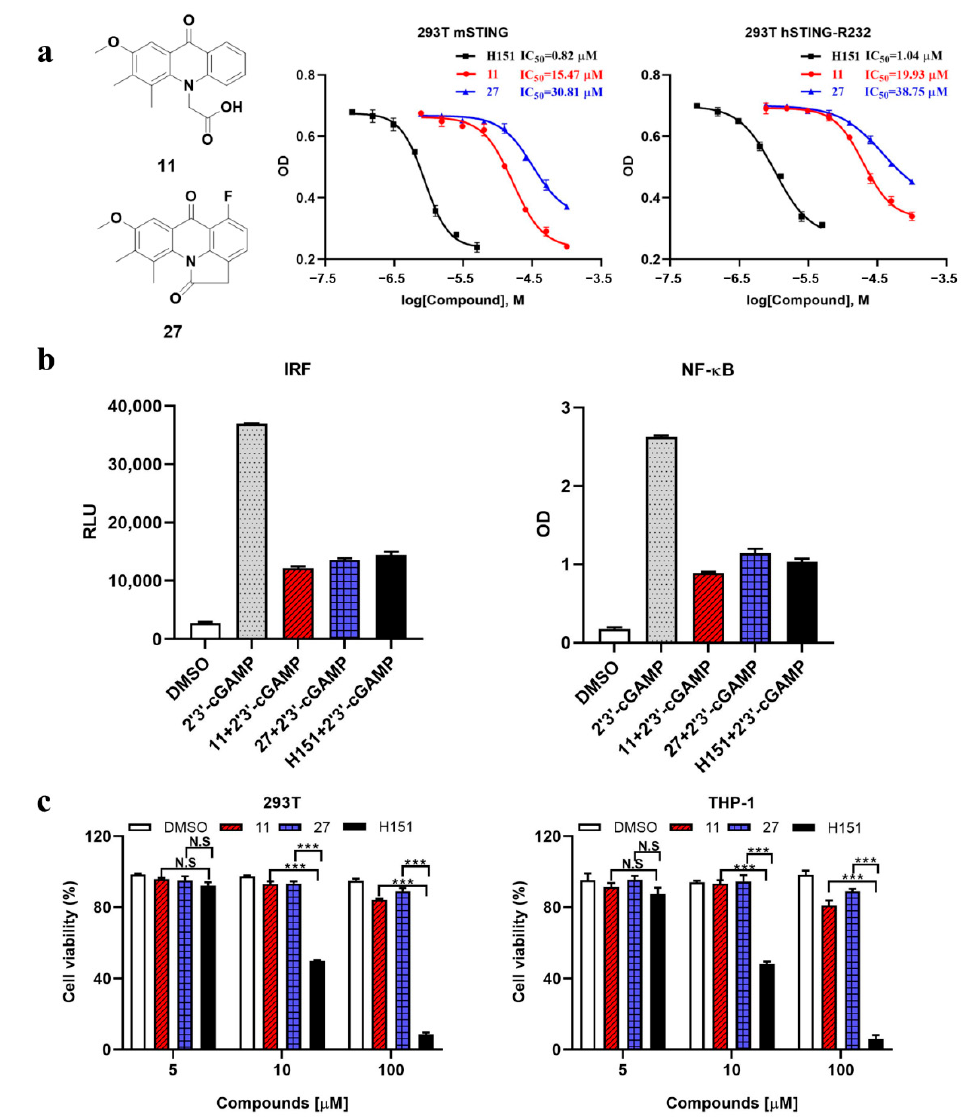
Figure 7. Broad-spectrum STING-binders 11 and 27 are STING antagonists. ( a ) Chemical structures of compounds 11 and 27 , and the inhibitory activity of STING inhibitors against both m- and h- STING pathways. 293T cells (mSTING or hSTING), pretreated with different concentrations of compounds were stimulated by 2 ′ ,3 ′ -cGAMP; inhibition of the IRF pathway activity was indirectly measured by optical density (OD) values. The dose-dependent inhibitory curve was fitted to calculate the IC 50 s of compounds. ( b ) Compounds 11 and 27 can inhibit the activation of hSTING dual pathways. THP1-hSTING-R232 reporter cell lines were stimulated with 2 ′ ,3 ′ -cGAMP, and treated with the compounds, inhibiting the IFN- β induction (assessing the activity by the relative light units (RLU) of Lucia luciferase) and proinflammatory cytokine induction (monitoring the activity of SEAP measured by OD values). ( c ) New analogs exhibit low cytotoxicity in comparison with the covalent inhibitor. 293T (or THP-1 cells) were incubated with the indicated concentration of inhibitors for the indicated time periods. Cell viability was measured by CellTiter-Glo kits. Data shown are the mean from three independent experiments. N.S (no significant) p > 0.05, *** p < 0.001. p values were calculated by two-tailed t-test.